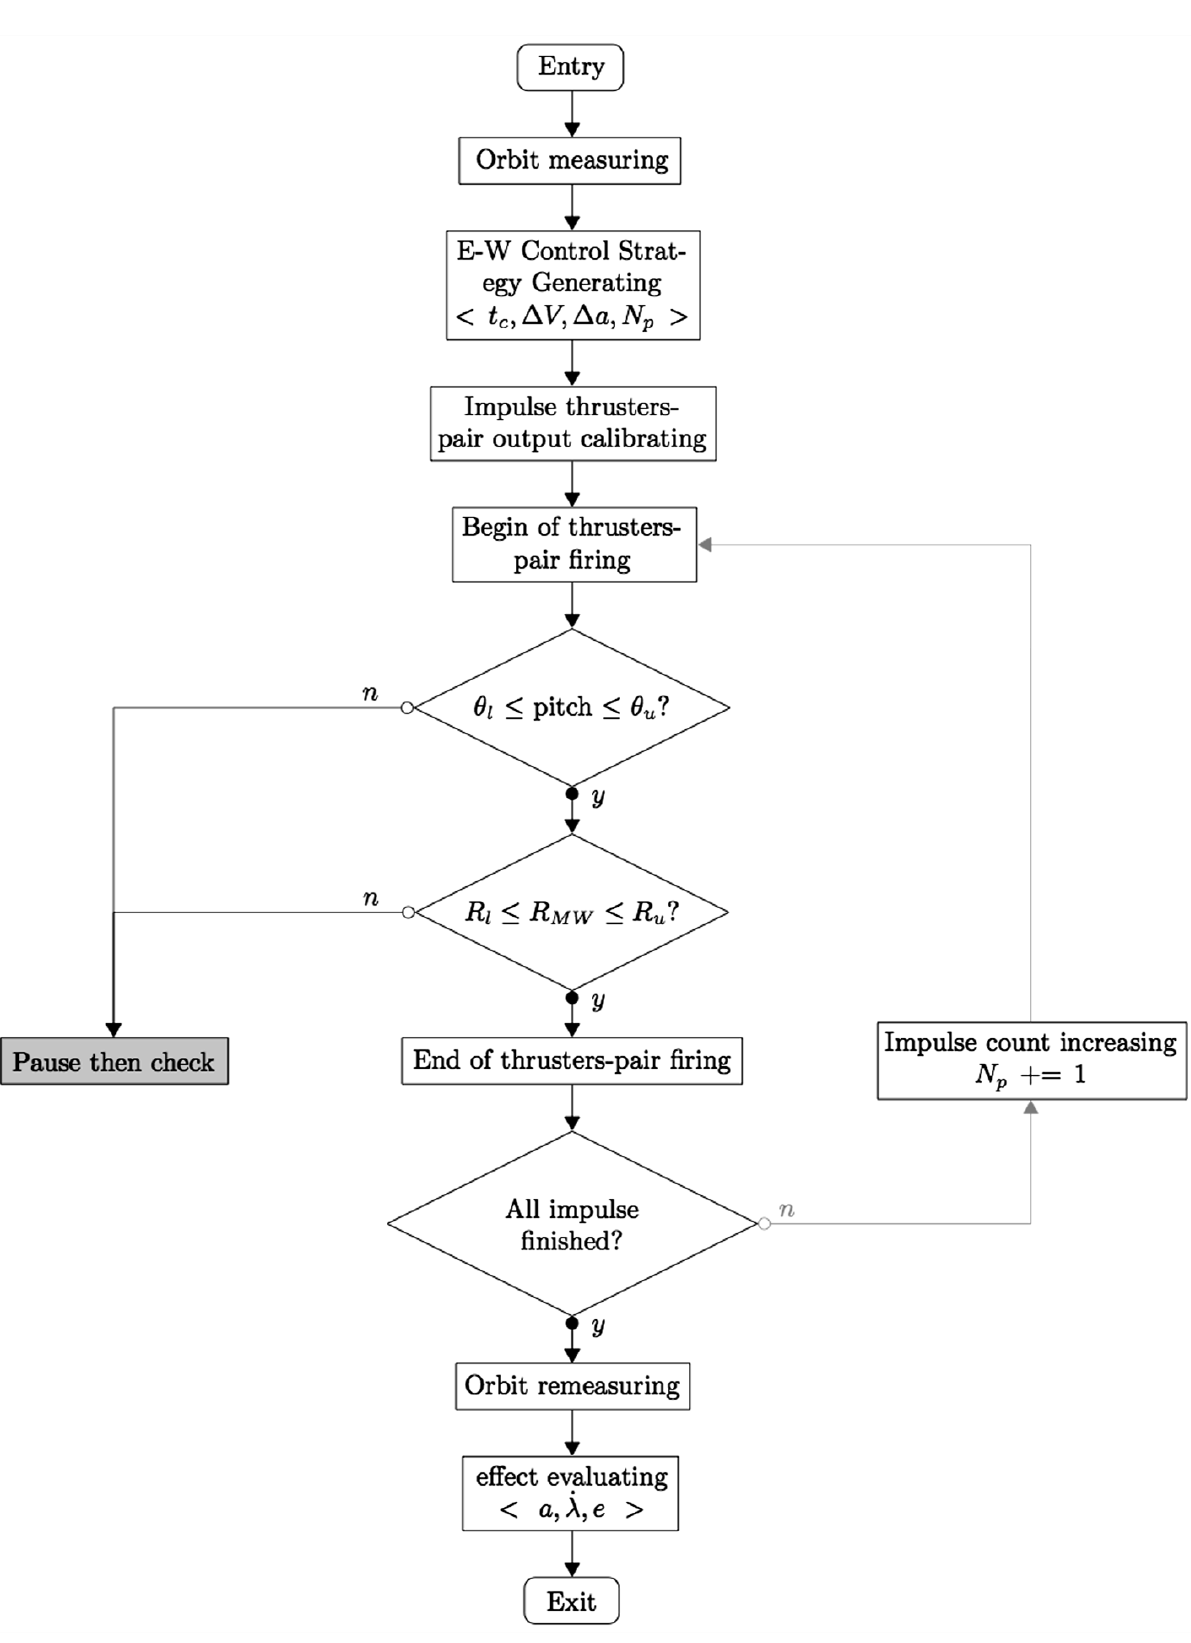
Figure 14. Nominal thruster